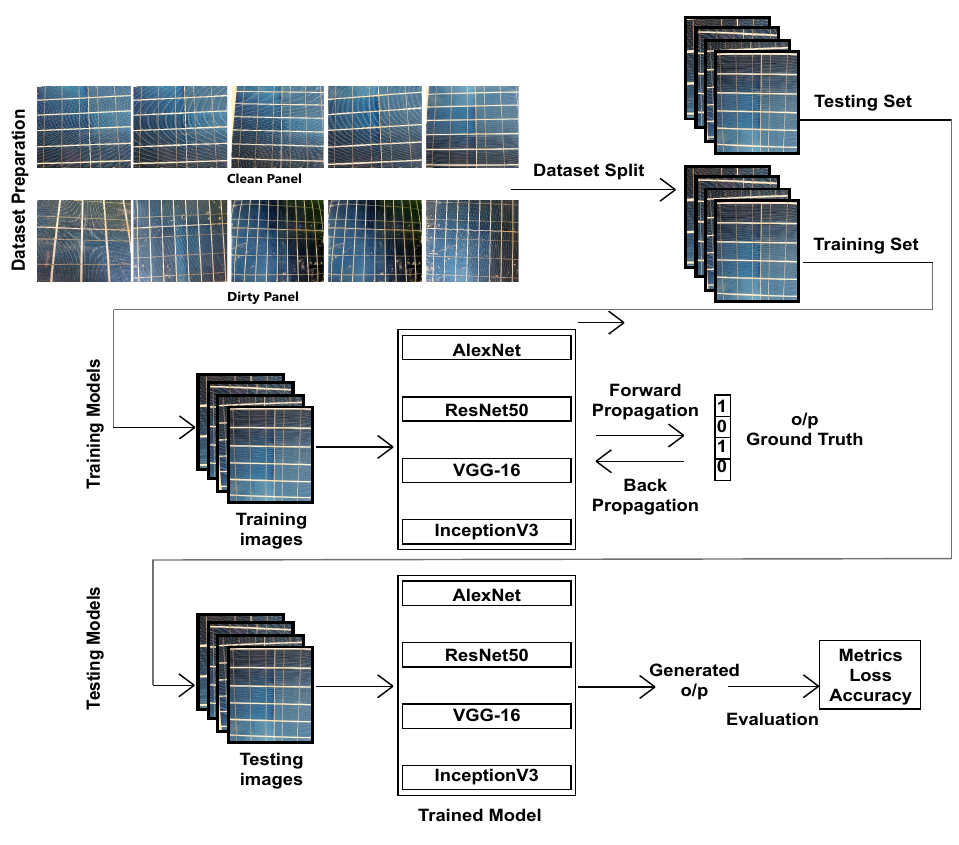
Figure 2. Workflow of our work.